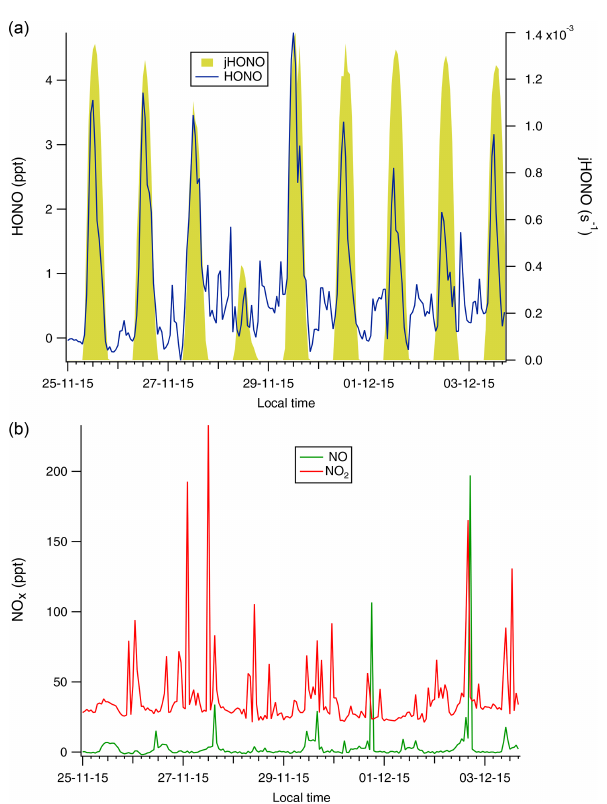
Figure 2. Time series of the measured HONO and j HONO (a) and NO x (b) mixing ratios at WAO. Red bars on the HONO time series x axis indicate marine air periods at WAO. Note the larger verti- cal axis scales, indicating that greater concentrations of HONO and NO x were observed at WAO compared to the CVAO data shown in Fig. 1.